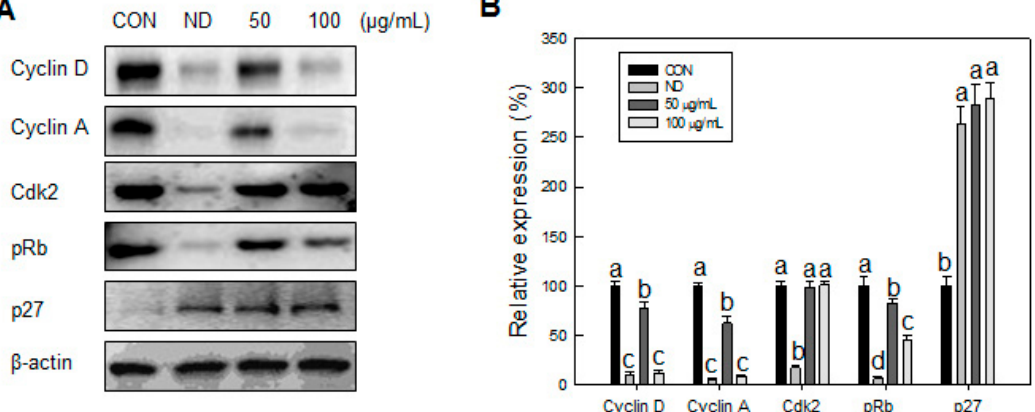
Figure 6. Effects of SN on cell cycle progression of 3T3-L1 cells during differentiation. ( A ) After differentiation. After 24 h of differentiation, cells were lysed for analysis of cyclins and cdk2 by Western blotting and ( B ) levels of cell cycle regulatory genes were quantified using the ImageJ software. CON: control, SN: seapolynol, ND: non-differentiated 3T3-L1. Data are presented as means ± SD from three replicate experiments. Means not designated by a common superscript are significantly different ( p < 0.05).